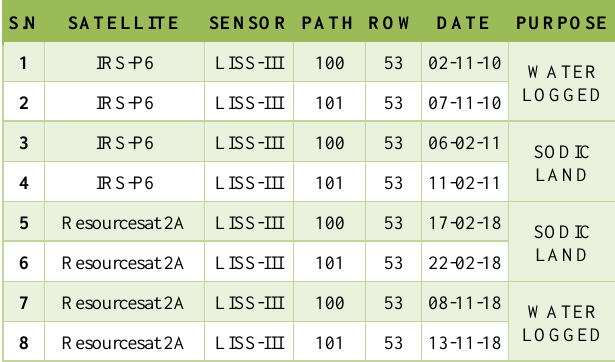
Table 1: Description of datasets used 3.